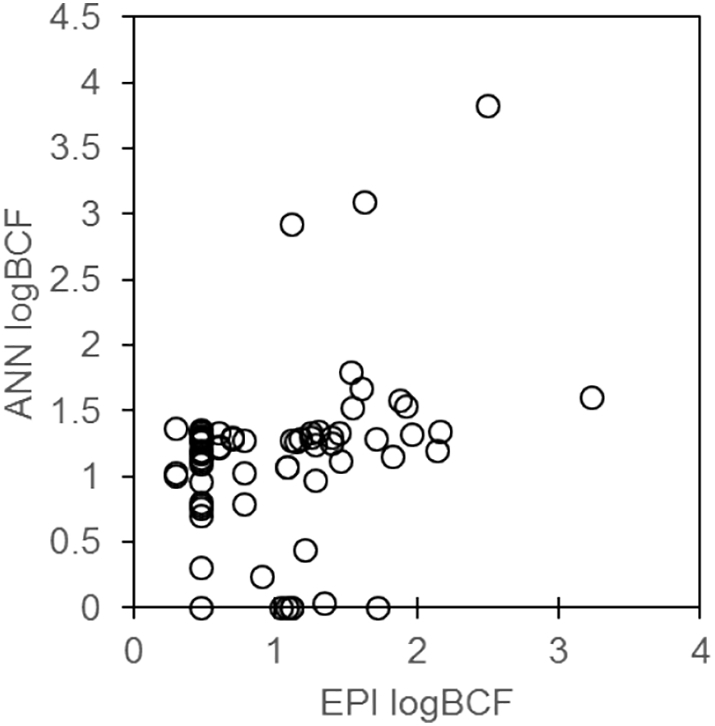
Comparison of predicted logBCF data from EPI suite and ANN model, for individual raw values please see SI Table S5.